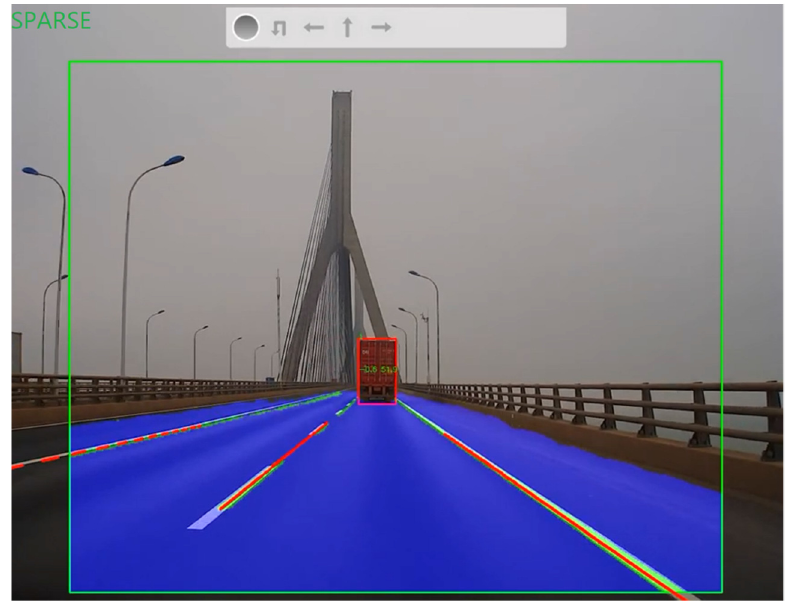
Figure 15. RTDE example output 4—SPARSE scenario.